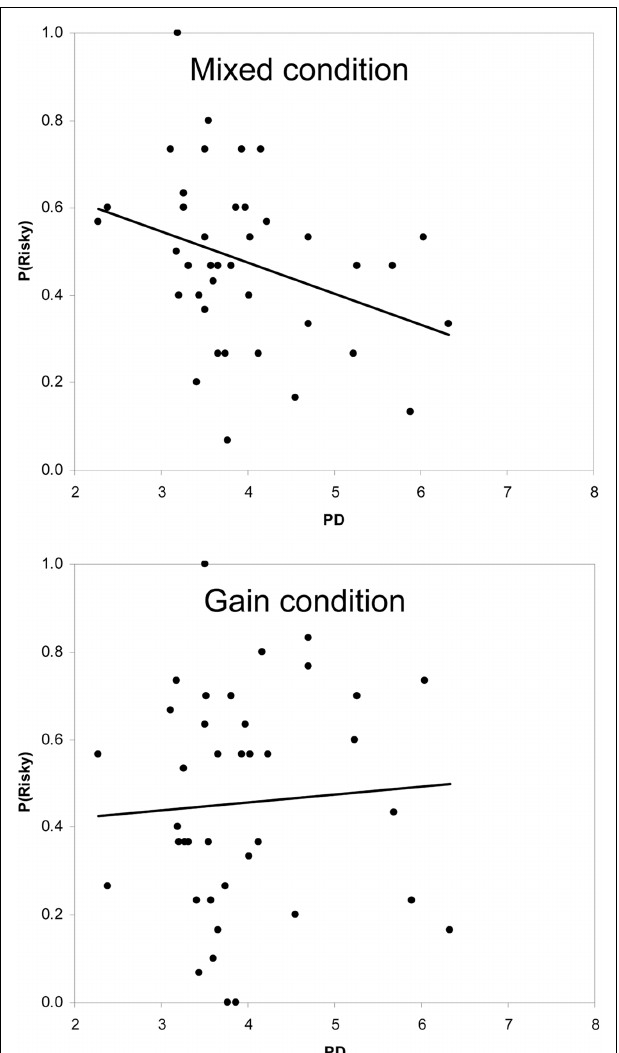
FIGURE 4 | Scatter plot and regression lines of the proportion of risky selections across trials by pre-task PD in Study 3. Top: Mixed condition. Bottom: Gain